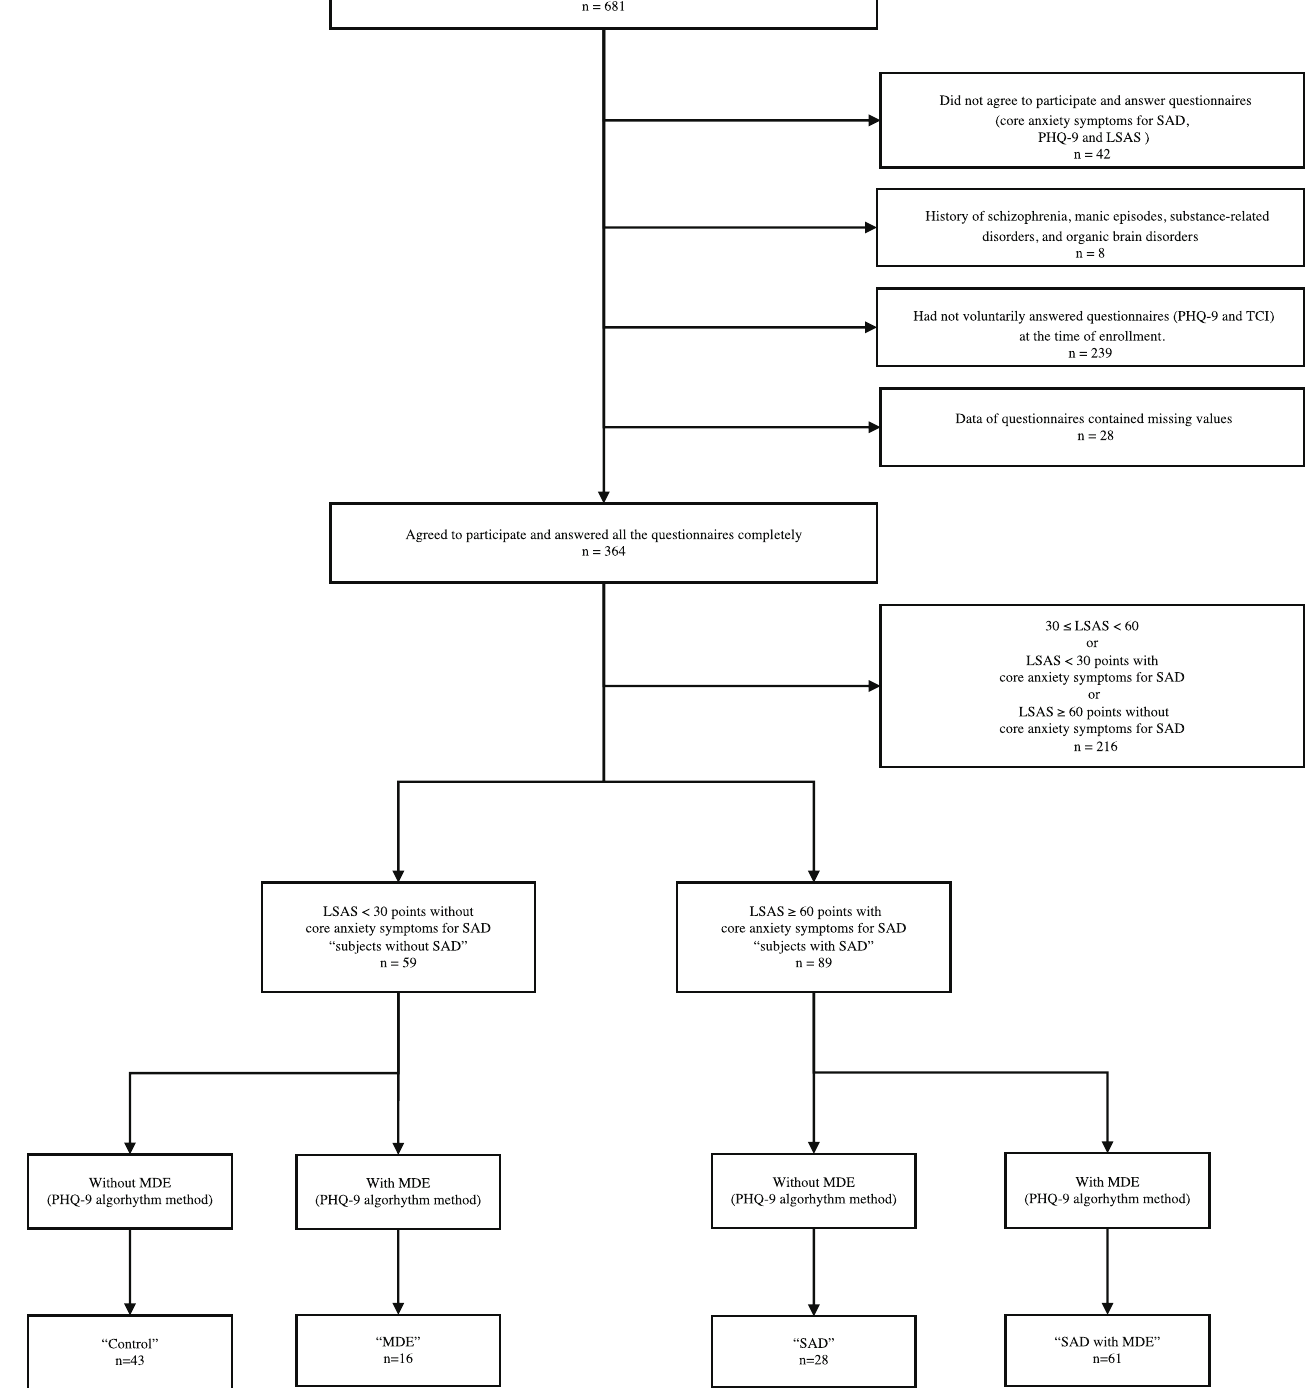
Fig 1. Samples and procedure flow. Notes: The “Control” group consisted of those with LSAS total score < 30, neither core anxiety symptoms for SAD, nor MDE. The “MDE” group consisted of those with LSAS total score < 30, neither core anxiety symptoms for SAD, and MDE according to the PHQ-9 algorithm scoring method. The “SAD” group consisted of those with core anxiety symptoms for SAD, LSAS total score � 60 but not MDE. The “SAD comorbid with MDE” group consisted of subjects with core anxiety symptoms for SAD, a LSAS total score � 60 and MDE according to the PHQ-9 algorithm scoring method. LSAS, Liebowitz Social Anxiety Scale; MDE, major depressive episode; PHQ-9, patient health questionnaire-9; SAD, social anxiety disorder; TCI, temperament and character inventory.